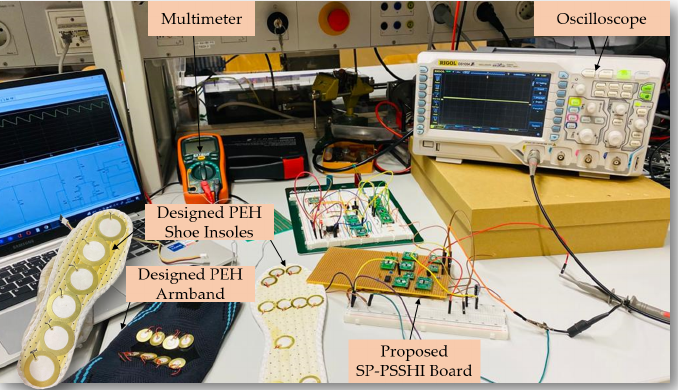
Figure 13. Experimental setup for laboratory characterization of the proposed energy management interface and storage